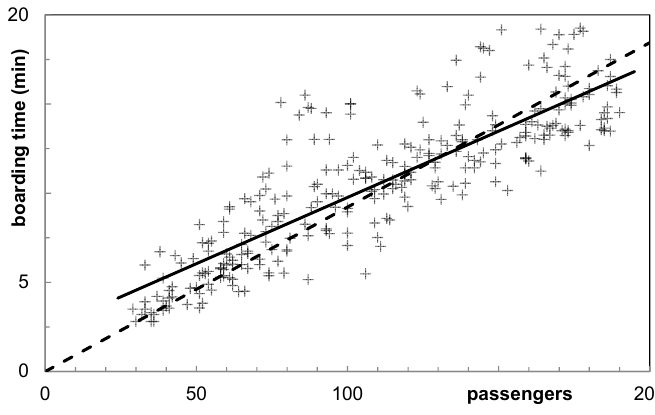
Figure 3. Boarding times of 282 measured flights with different number of passengers assuming a linear correlation between passengers and boarding time with both defined offset (bold line) and no offset (thin line).